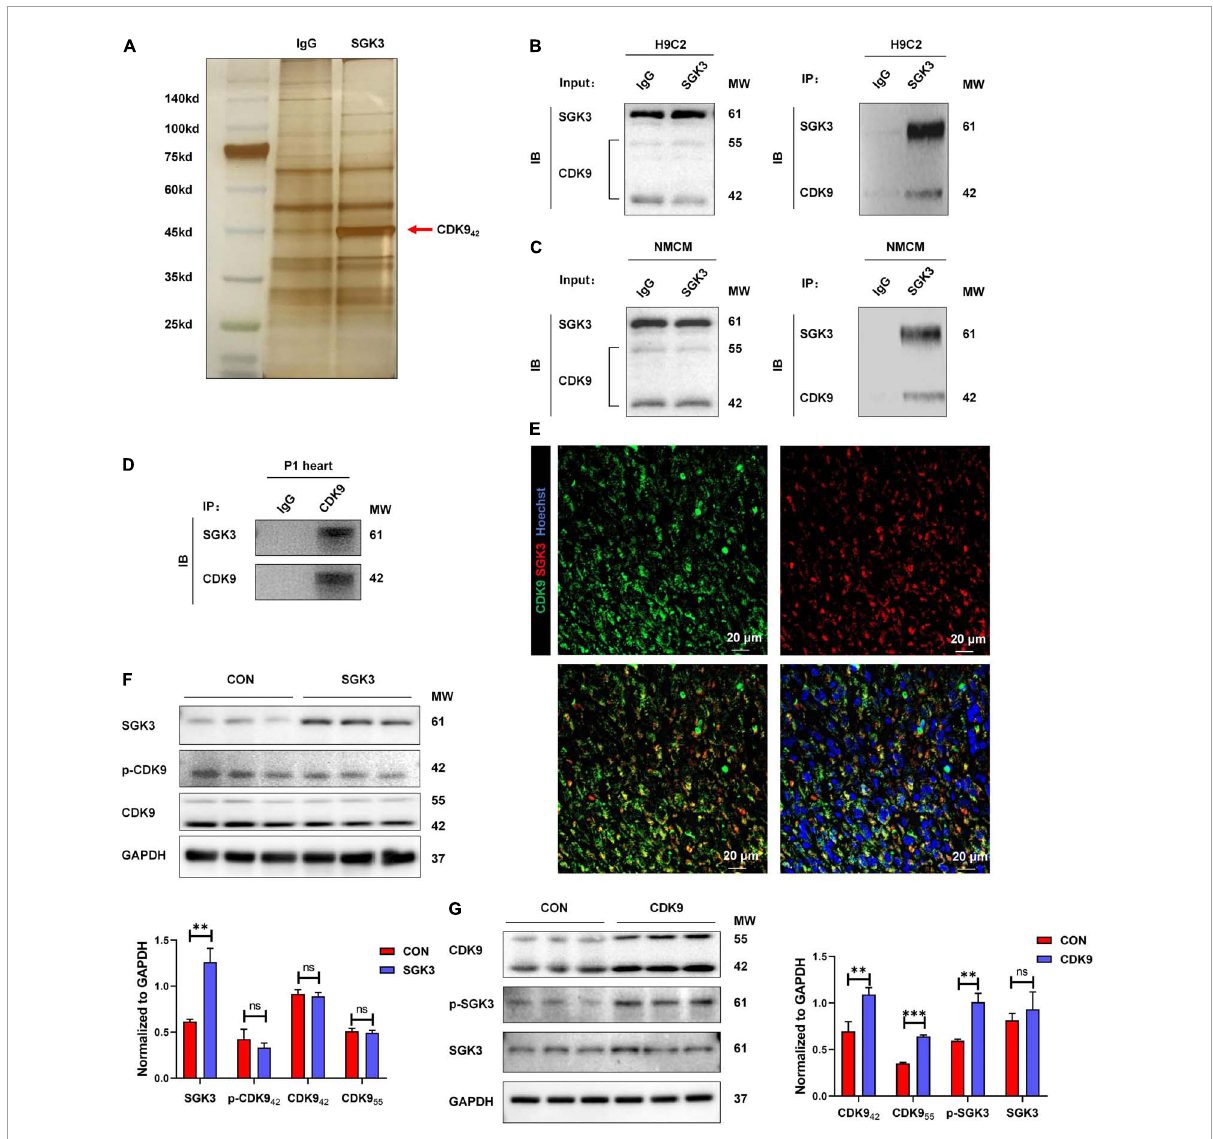
FIGURE1 CDK9 interacts with SGK3 and enhances SGK3 activity. (A–D) Silver staining of a gel showing SGK3 and the control IgG pulldown proteins (CDK9, 42 kDa, red arrow) (A) . Co-immunoprecipitation reveals that CDK9 42 interacts with SGK3 in the H9C2 cell line (B) , neonatal CMs (C), and P1 heart (D) . (E) Co-localization of SGK3 and CDK9 in neonatal myocardium was detected by immunofluorescence. (F) SGK3, phosphorylated (p-) CDK9 and CDK9 proteins were detected by Western blot in CMs transfected with Ad5: cTnT-SGK3 (MOI = 50). (G) CDK9, SGK3 Thr320 and SGK3 proteins were detected by Western blot in CMs transfected with Ad5: cTnT-CDK9 (MOI = 50). CMs indicate cardiomyocytes, MW indicates molecular weight, MOI indicates a multiplicity of infection; statistical significance was calculated with the unpaired Student t -test; data are presented as mean ± SEM, ∗∗ P ≤ 0.01, ∗∗∗ P ≤